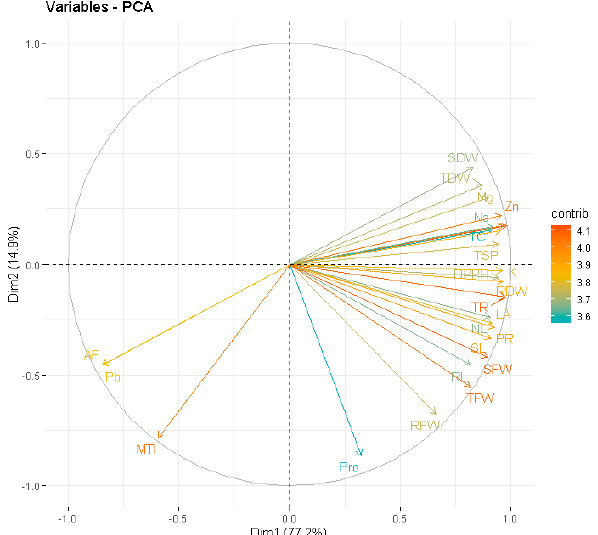
Figure 4. Loading plots of principal component analysis (PCA) showed a relationship between the growth and physiological parameters of Phaseolus vulgaris L. grown under Pb soil with the applica- tion of Tria as seed primer. Different abbreviations used in the figure are as follows: SL (shoot length), RL (root length), NL (number of leaves), LA (leaf area), SFW (shoot fresh weight), RFW